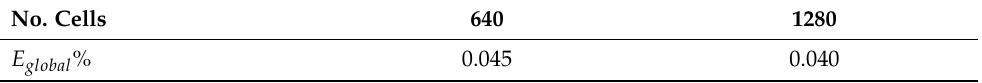
Table 2. Relative error of mass in the cavitatingTank test case for the two grids tested. No. Cells 640 1280 E global % 0.045